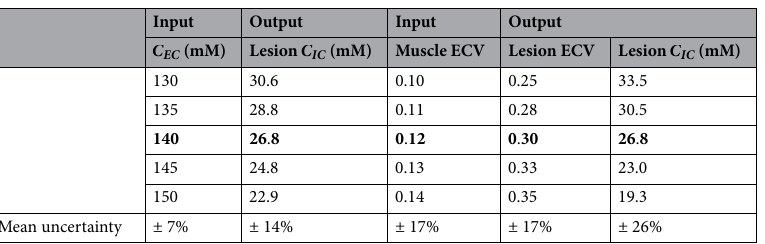
Table 1. Error propagation due to uncertainty on C EC and ECV of muscle. On the left side the mean C IC in an ROI containing the lesion (Patient 1 in Fig. 5) is reported for different values of C EC . On the right side mean ECV and C IC in the lesion are reported for different values of the muscle ECV. In the last row the mean uncertainty, defined as mean percentage variation relative to the central values, is reported. The values of C EC and muscle ECV we used in our method and the corresponding mean C IC and ECV in the lesion are highlighted in bold. Notations are: C EC extracellular sodium concentration, C IC intracellular sodium concentration, ECV extracellular volume